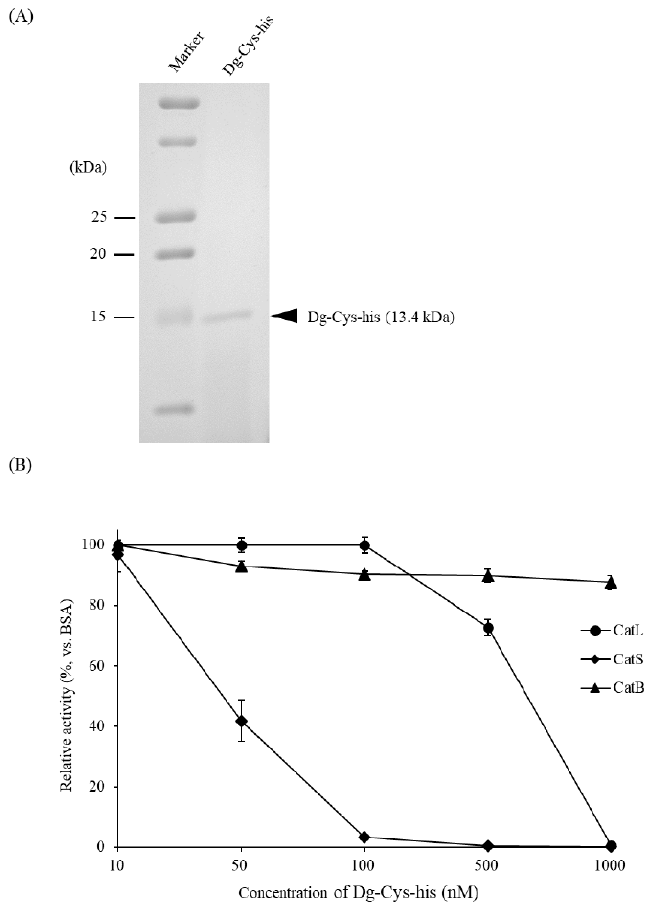
Figure 3. Functional analysis of recombinant Dg-Cys . ( A ) The recombinant protein of Dg-Cys ( Dg-Cys -his) was prepared using BIC system. Purified Dg-Cys -his was separated by SDS-PAGE and visualized by staining with Coomassie brilliant blue. ( B ) Inhibitory properties of Dg-Cys -his against cysteine proteases were examined. Cathepsins L, S, and B were incubated with their fluorometric substrates in the presence of Dg-Cys -his or bovine serum albumin (BSA). The X-axis indicates the concentrations of Dg-Cys -his. The Y-axis indicates relative enzymatic activities of each cysteine proteases in the presence of Dg-Cys -his compared to those in the presence of BSA. The assays were performed in triplicate, and error bars indicate